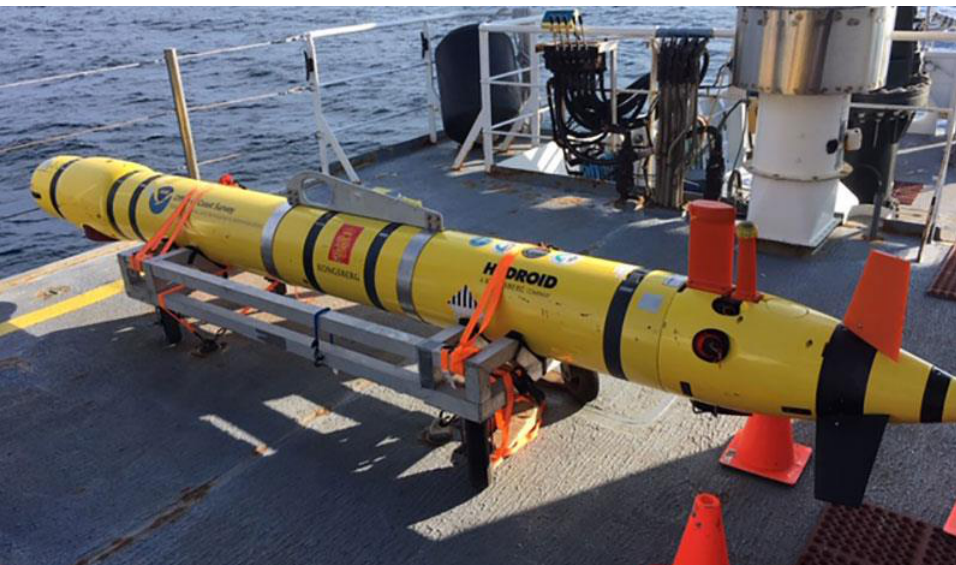
Figure 2. Remus 600 unmanned underwater vehicle used by the National Oceanic and Atmospheric Administration (NOAA) [4]. Image used is consistent with NOAA policy, “NOAA still images, audio files and video generally are not copyrighted. You may use this material for educational or informational purposes, including photo collections, textbooks, public exhibits, computer graphical simulations and webpages.” [2].